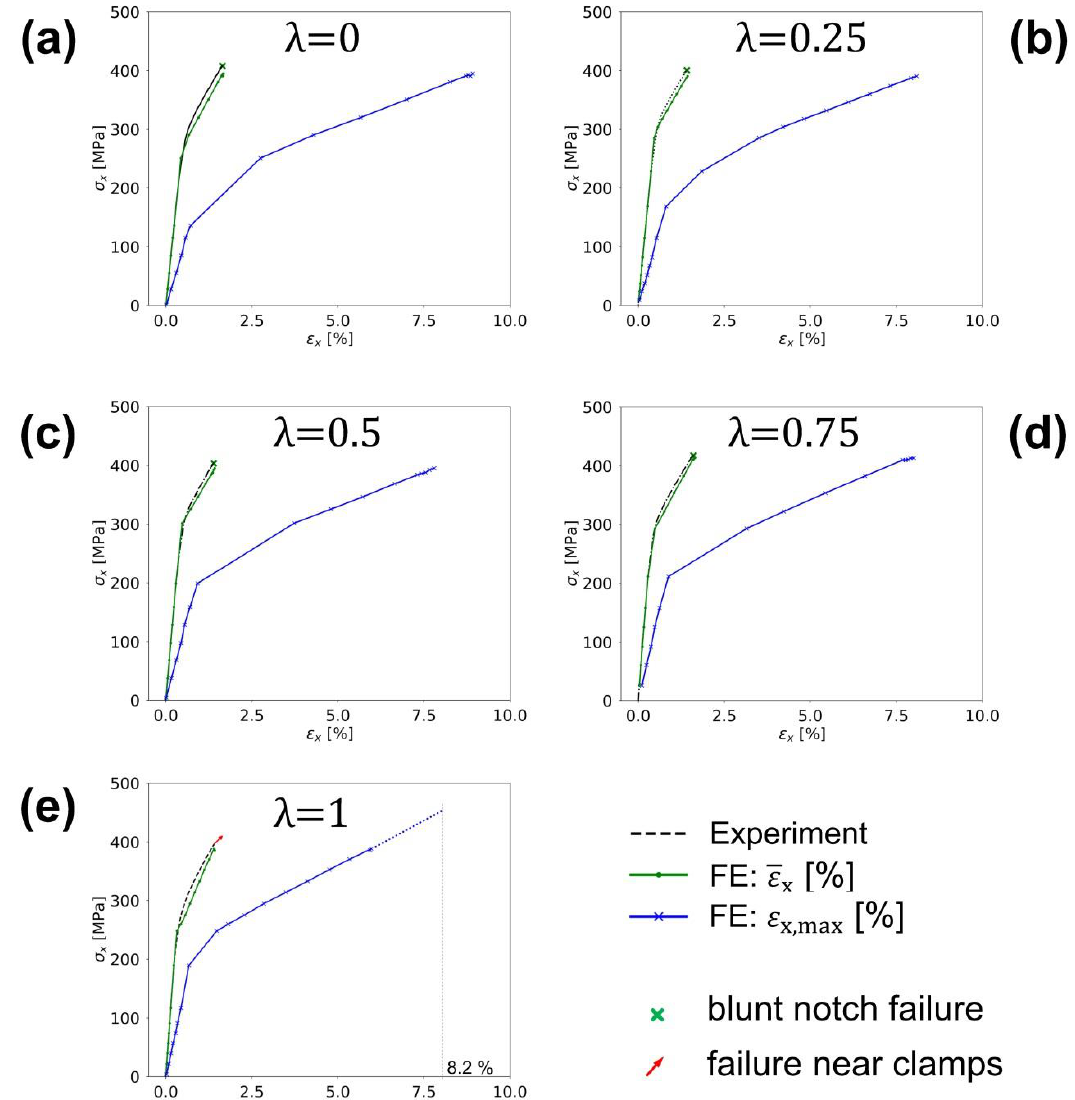
Figure 10. Comparison of the stress-strain curves obtained from the experiments and the FE simulation.